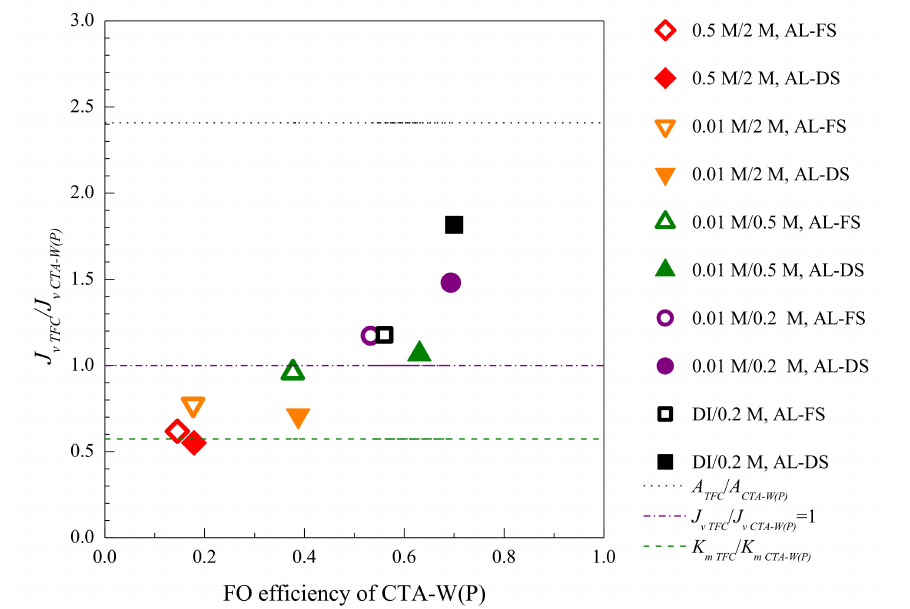
Figure 8. The FO efficiency of benchmark membrane (CTA-W(P)) and J v TFC /J v CTA-W(P) in different testing conditions. DI water, 0.01 M and 0.5 M NaCl were used as FS; 0.2 M, 0.5 M, and 2 M NaCl were used as DS, as in the